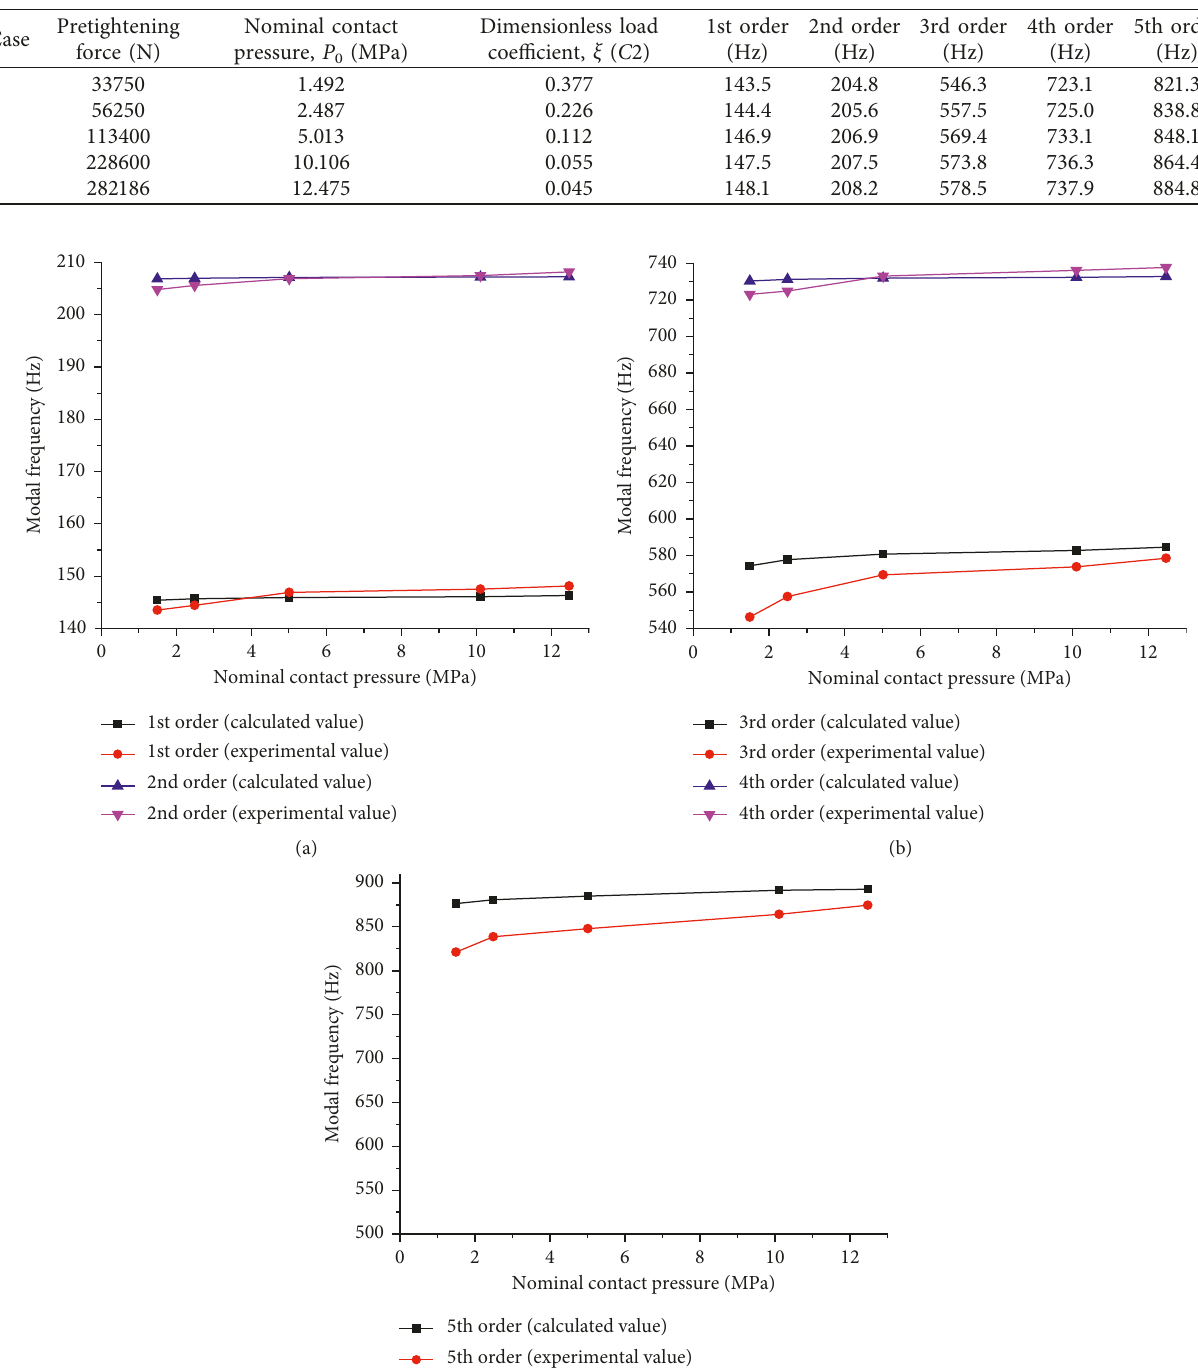
Figure 14: The modal measurement Table 5: Experimental results of flexural vibration modal frequencies of the experimental rod-fastened rotor.